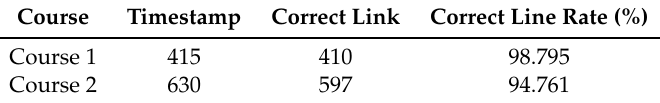
Table 2. Results of link extraction.